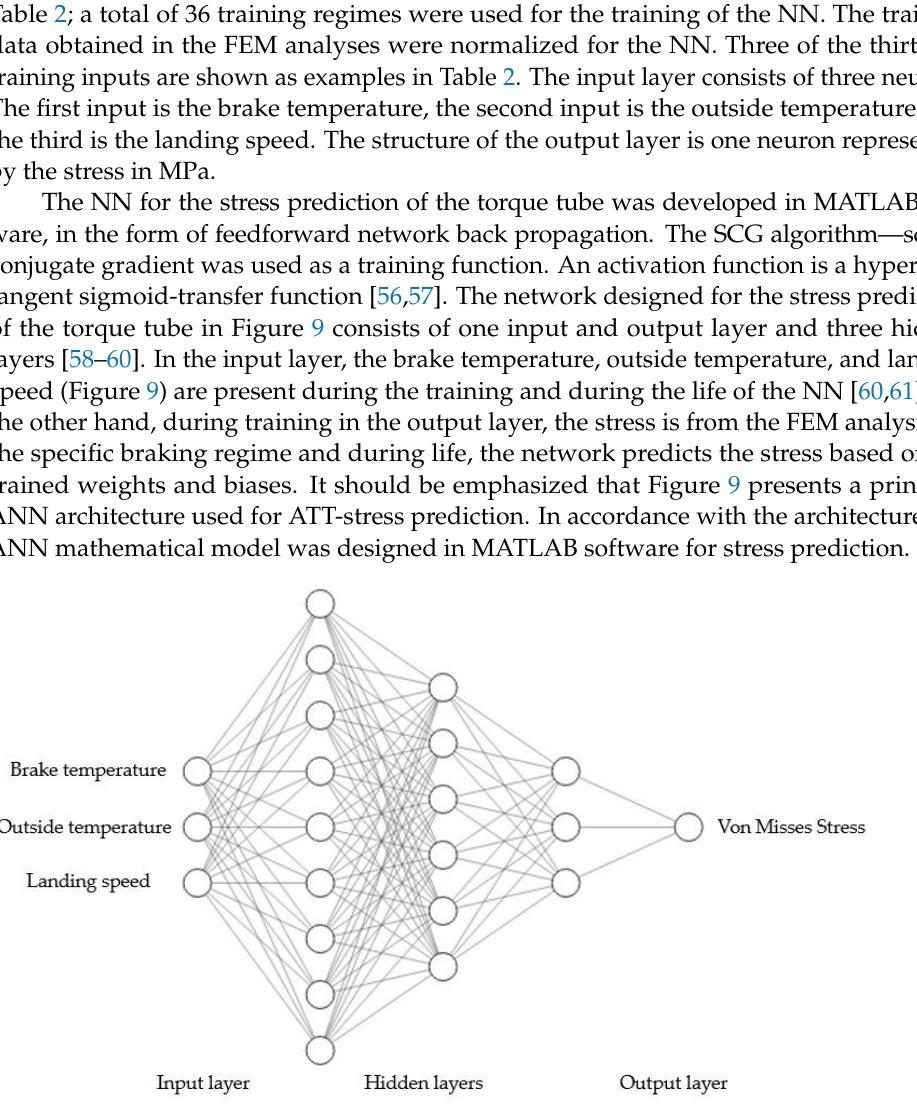
Figure 9. An architecture of the neural network for stress prediction.